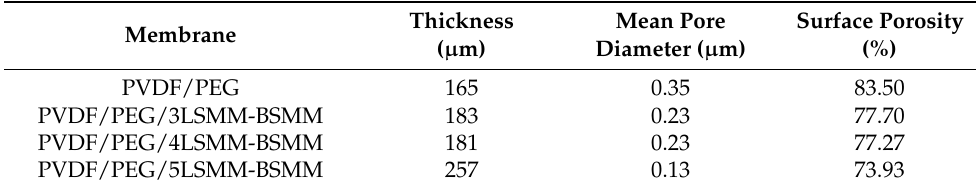
Table 3. Properties of membranes with respect to membrane thickness, average pore size, and surface porosity.